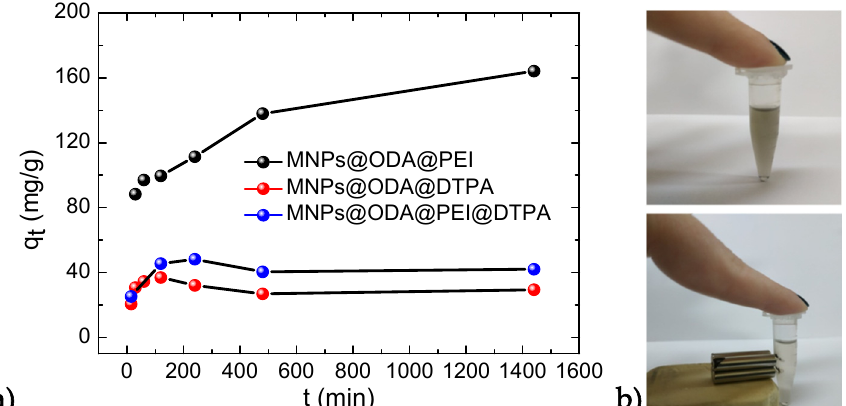
Figure 7. ( a ) E ff ect of time on the adsorption process and ( b ) magnetic separation by external Figure 7. (a) Effect of time on the adsorption process and (b) magnetic separation by external magnet.